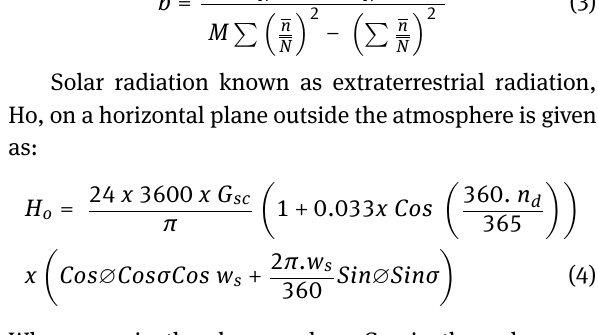
ules, the storage battery, the battery charger controller and the inverter are